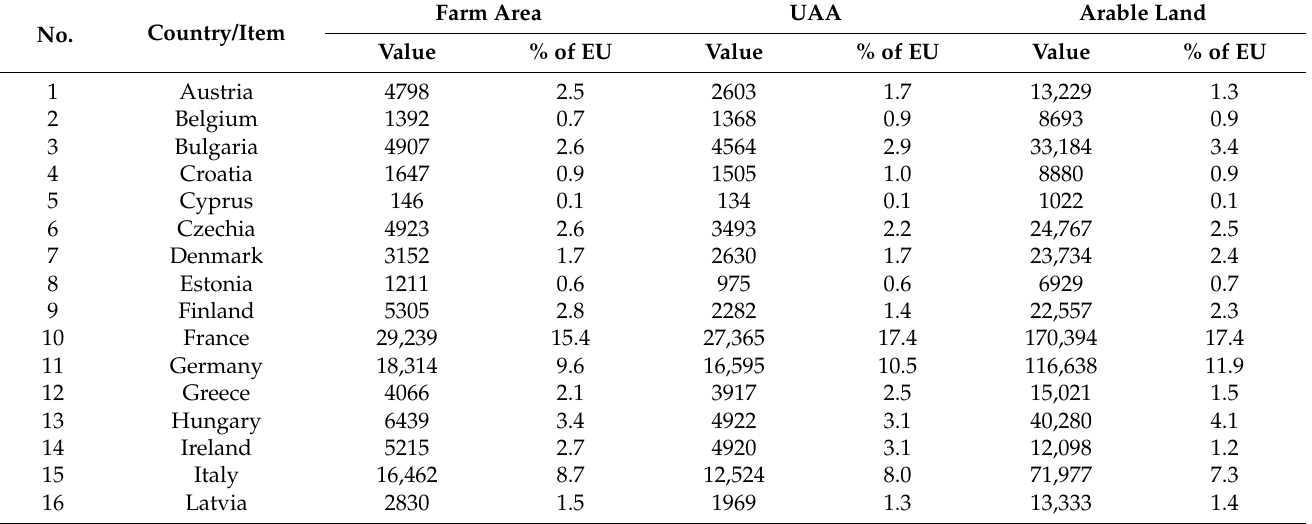
Table 1. EU agricultural land use, 2020 (thousand